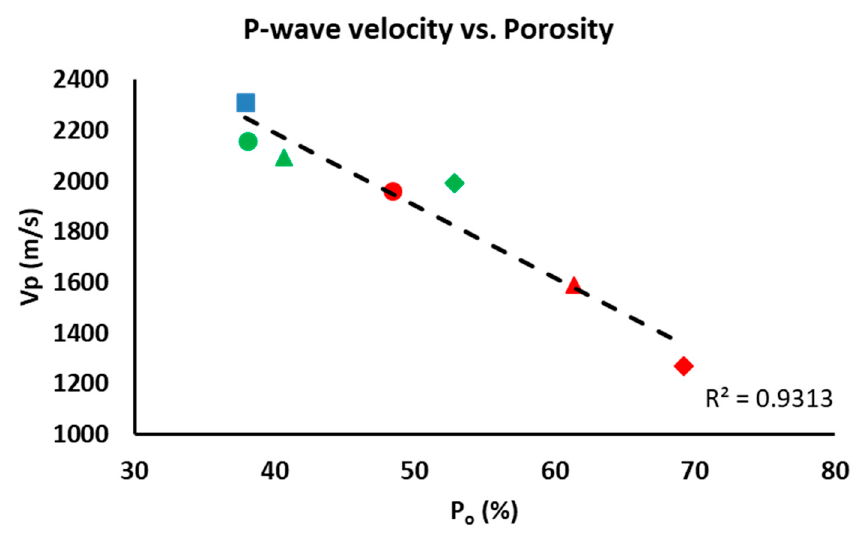
Figure 8. Comparison between the open porosity of the samples (P o ) and the P-wave velocity (Vp). This figure shows control samples (blue square), samples with EPS (green) and samples with olive stones (red) at 20% (circle), 40% (triangle) and 60% (diamond).